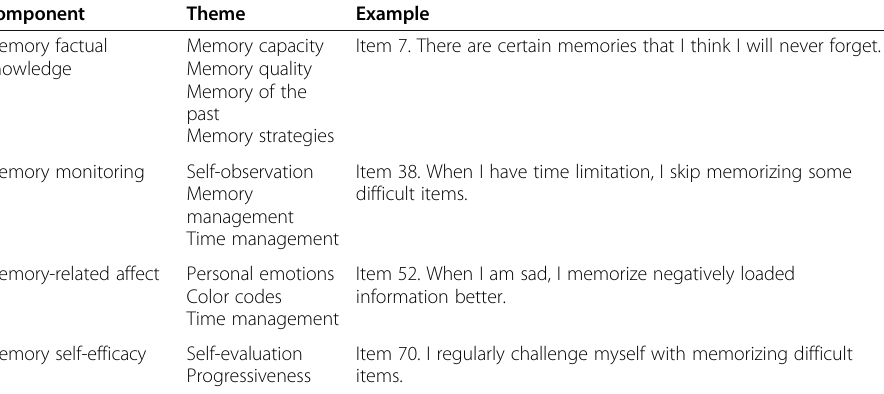
Table 2 Initial components and retrieved themes in the MMM questionnaire Component